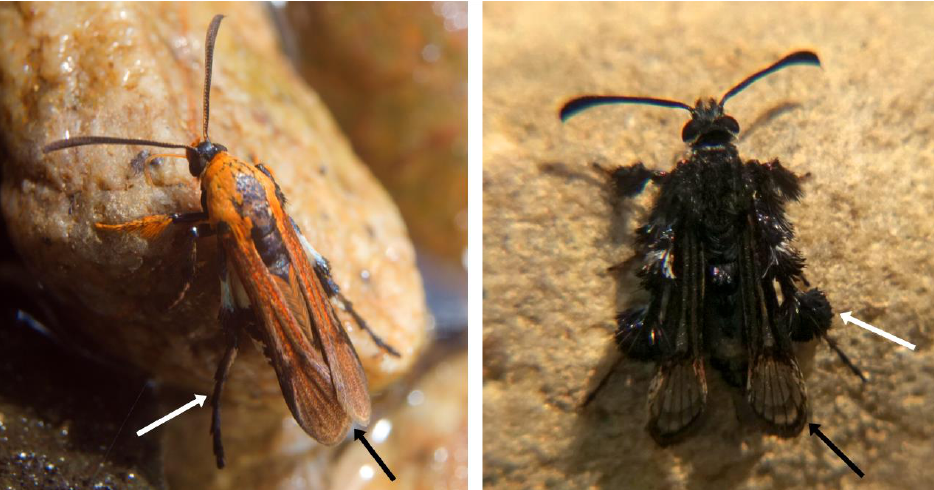
Figure 2. Representatives of Aurantiosphecia gen. nov. and Aschistophleps Hampson, 1893 can be immediately distinguished in the field. Left: Aurantiosphecia piotrii gen. et sp. nov. has long wasp-like hind legs without conspicuous tufts of elongated scales and rests with forewings overlapping. Right: Aschistophleps argentifasciata Skowron Volponi, 2018 has strongly tufted hind legs and rests with forewings not overlapping. White arrows indicate differences in the hind legs, black arrows point to differences in the conformation of forewings in a typical resting position.